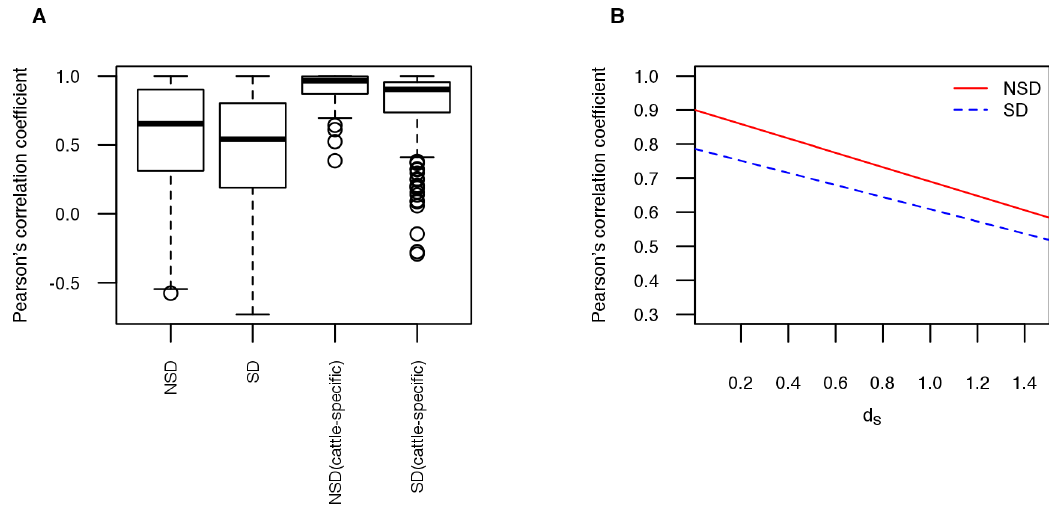
Figure 4. The relationship between Pearson’s correlation coefficient of gene expression and structural divergence. (A) Four different types of duplicate gene pairs: not structurally divergent (NSD), structurally divergent (SD), not structurally divergent cattle-specific (NSD cattle- specific), structurally divergent cattle-specific (SD cattle-specific). (B) The linear regression model with expression similarity as the dependent variable and the synonymous divergence as explanatory variable was constructed for both structurally divergent duplicate gene pairs and not structurally divergent duplicate gene pairs.